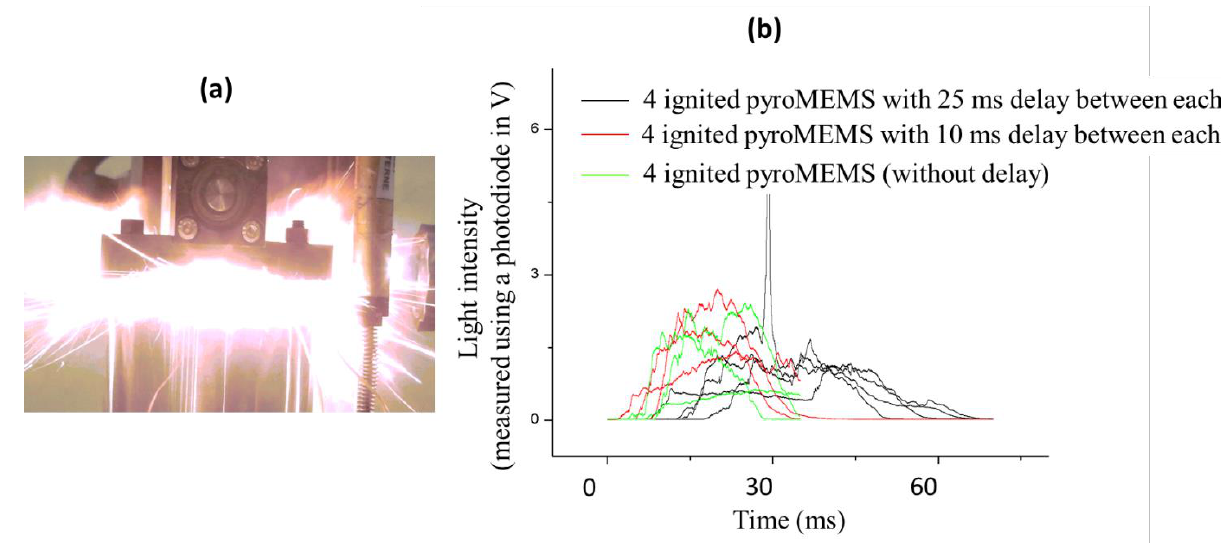
Figure 5. ( a ) Photo of the flame produced by the propellant used for demonstration, which is made of magnesium/Teflon/Viton and was ignited by four pyroMEMS. ( b ) Light emitted by the IR flare, with curves representing the different numbers of grooves ignited by the pyroMEMS. Black: 4 pyroMEMS sequentially ignited with a delay of 25 ms. Red: 4 pyroMEMS sequentially ignited with a delay of 10 ms. Green: 4 pyroMEMS ignited together.